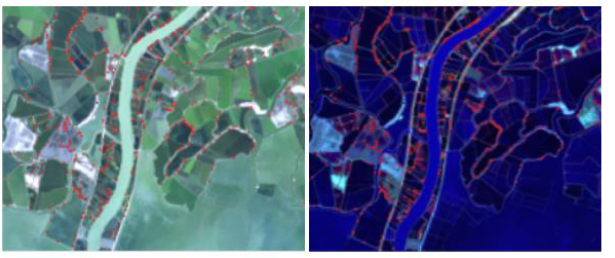
Figure 9. Misclassified/Noise Data.